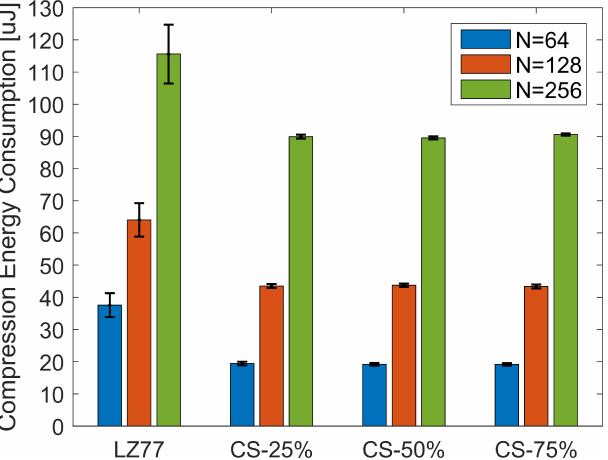
Figure 11. Average and standard deviation of CEC, over the total number of pressure blocks, for different compression